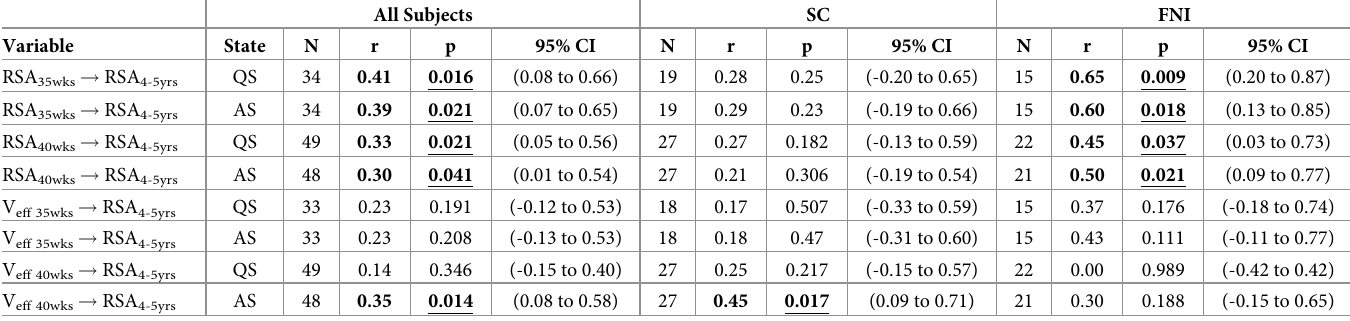
Table 6. Correlations between RSA and vagal efficiency in infancy (~35 and ~40 weeks postmenstrual age) and RSA at 4 to 5 years of age for all subjects combined and for Standard Care (SC) and Family Nurture Intervention (FNI) subjects